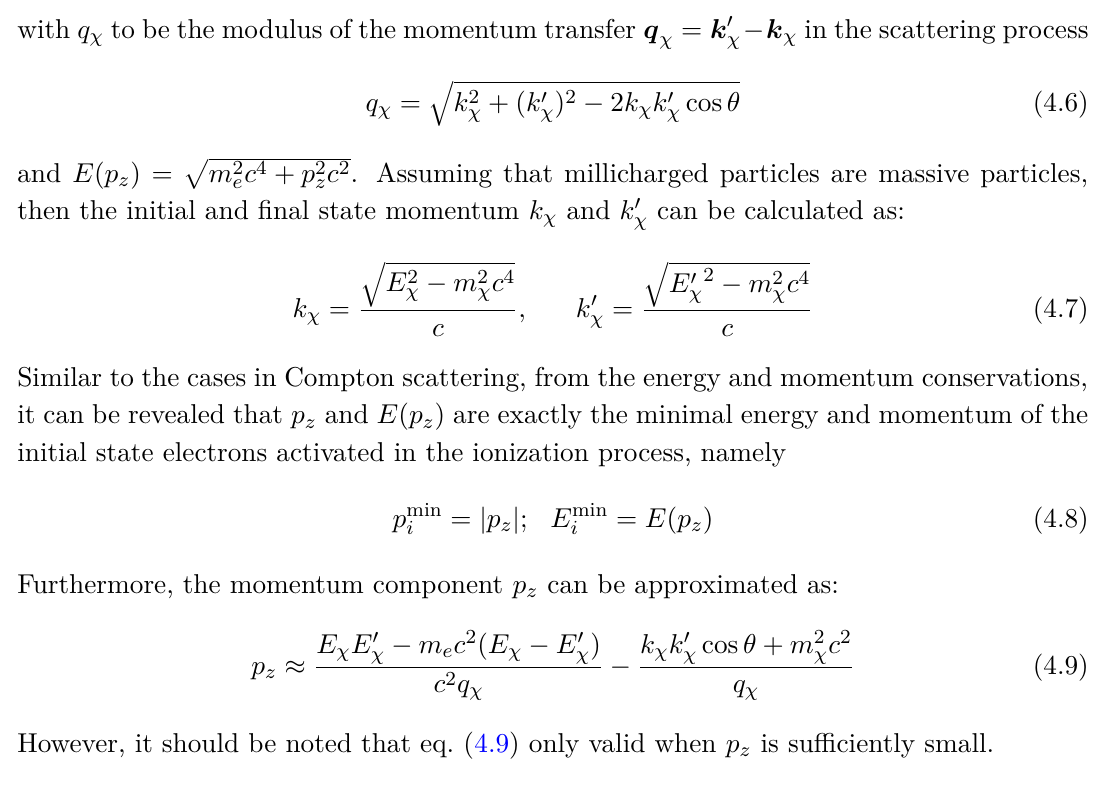
, and the momentum χ ≡ k 0 − k χ . In this coordinate, the χ χ